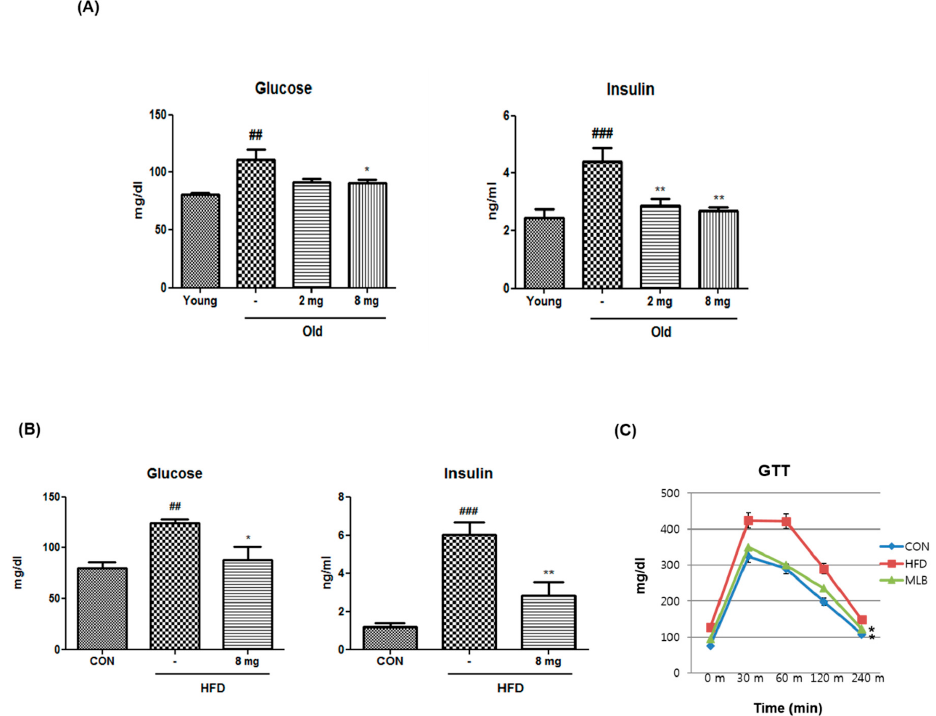
Figure 2. Effect of MLB on metabolic parameters. ( A ) Aged rats were treated for 20 days with MLB (2 or 8 mg/kg/day) and compared with MLB-untreated aged rats. ( B ) HFD-fed mice were treated for 24 days with MLB (8 mg/kg/day). ( C ) Glucose tolerance test following fasting for 18 h in C57BL/6J mice fed a standard chow or high-fat diet. The area under the curve was calculated for the statistics. Data represents the mean ± S.E.M. One-way analysis of variance (ANOVA) was used to determine the statistical result: ## p < 0.01, and ### p < 0.001 versus the young rats or the HFD-fed mice, * p < 0.05, ** p < 0.01 versus the MLB-untreated aged rats or HFD-fed mice. 2 mg, MLB 2 mg/kg/day; 8 mg, MLB 8 mg/kg/day; HFD, high-fat diet; GTT, glucose tolerance